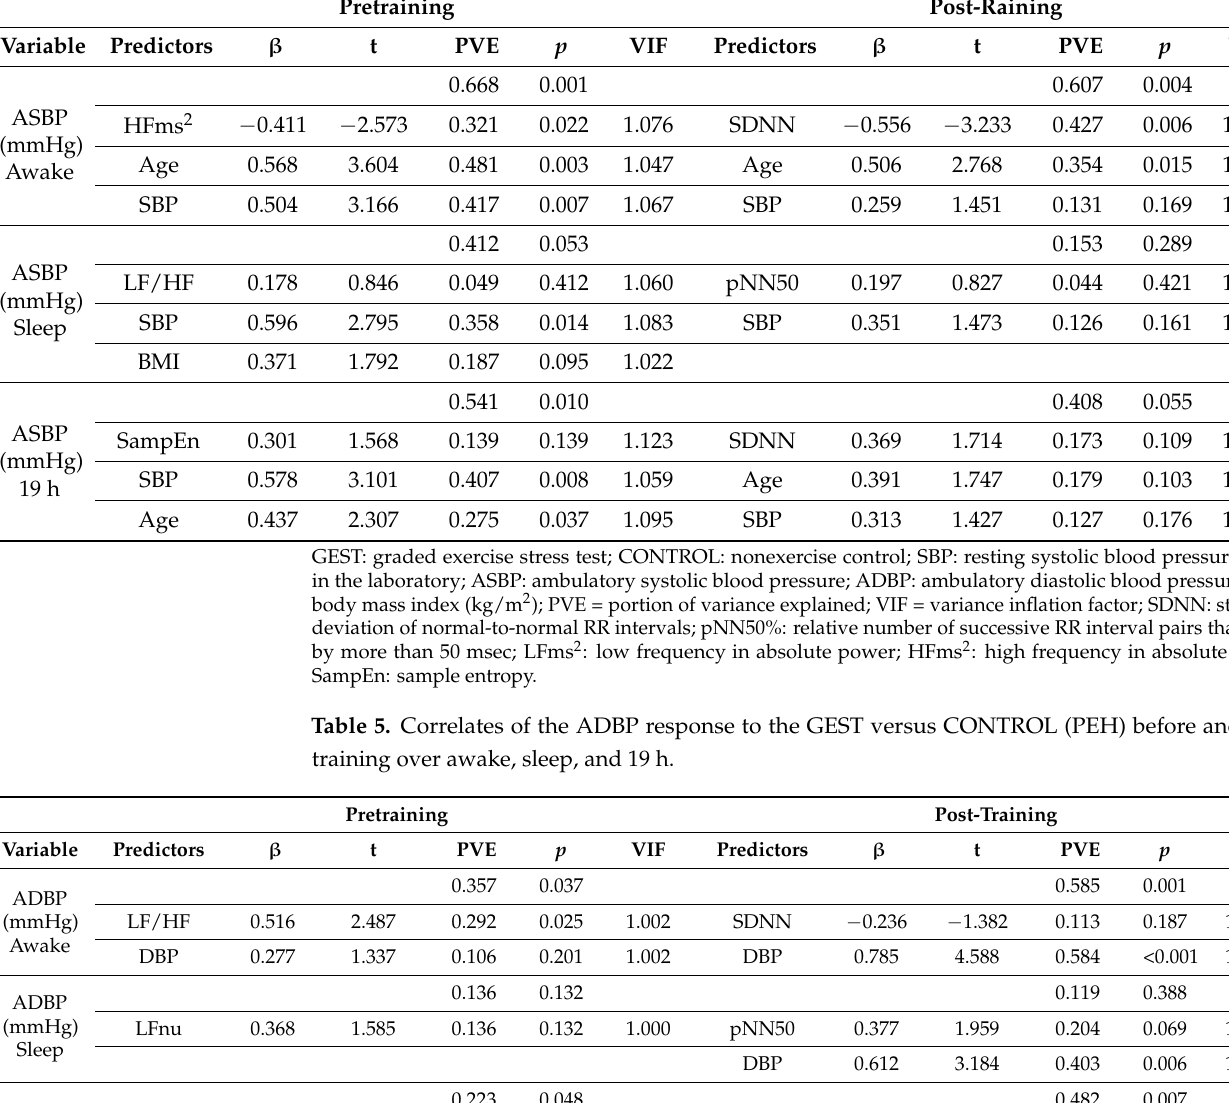
for 54.1% of the variation in the ASBP response over the same time period ( p = 0.010) (Table 4). As LF/HF ( β = 0.516) increased, ADBP over awake increased following the GEST versus CONTROL. The regression model comprising LF/HF and resting DBP ( β = 0.277, p = ns) explained 35.7% of the variance in the ADBP response over awake ( p = 0.037). As LF/HF ( β = 0.473) increased, ADBP over 19 h increased following the GEST versus CONTROL, accounting for 22.3% of the variation in the ADBP response over the same time period ( p = 0.048). There were no statistically significant models that emerged explaining a clinically important amount of the ADBP response over sleep (Table 5). Table 4. Correlates of the ASBP response to the GEST versus CONTROL (PEH) before and after training over awake, sleep, and 19 h. Pretraining Post-Raining